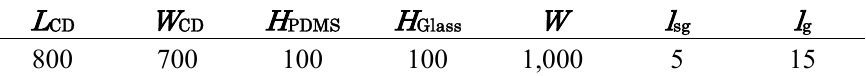
Table 1. Dimensions of the sensor ( μ m) in the numerical